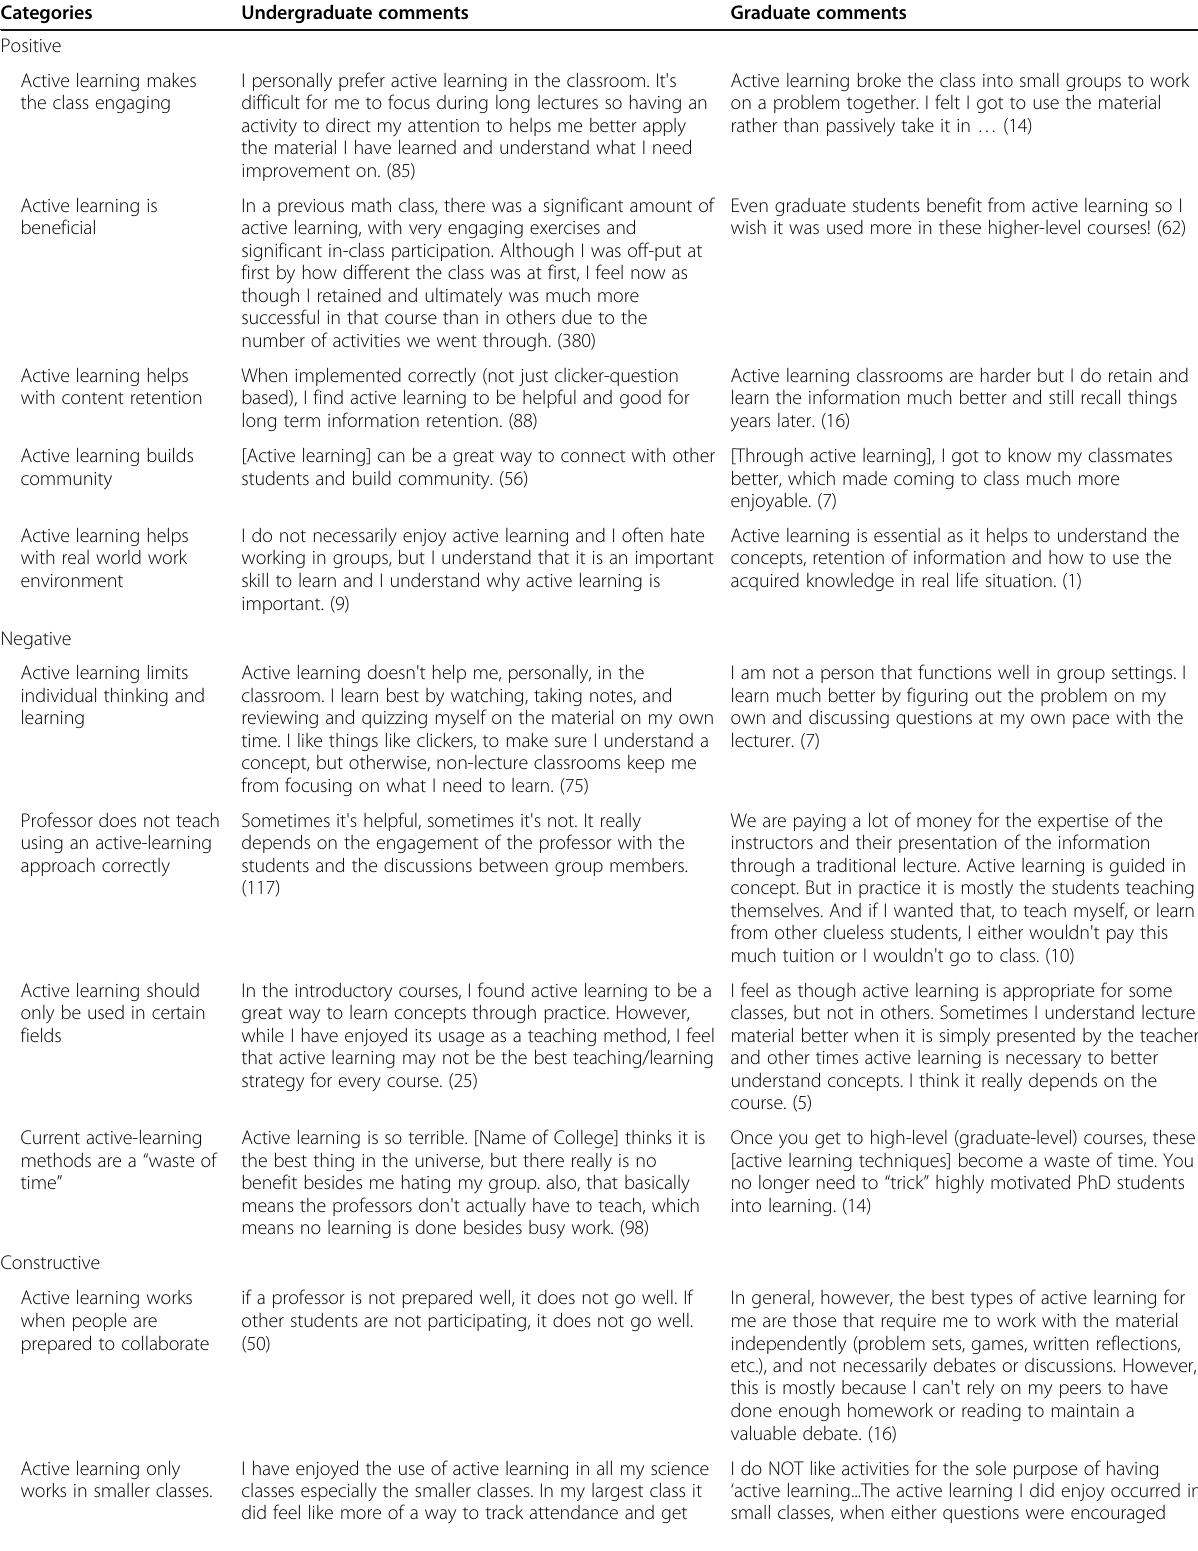
Table 4 Categories (Positive, Negative, and Constructive) and subcategories identified in student responses to the prompt “ Please describe your experiences with active learning in the classroom. ” Number of responses in each subcategory are included in parentheses after a sample